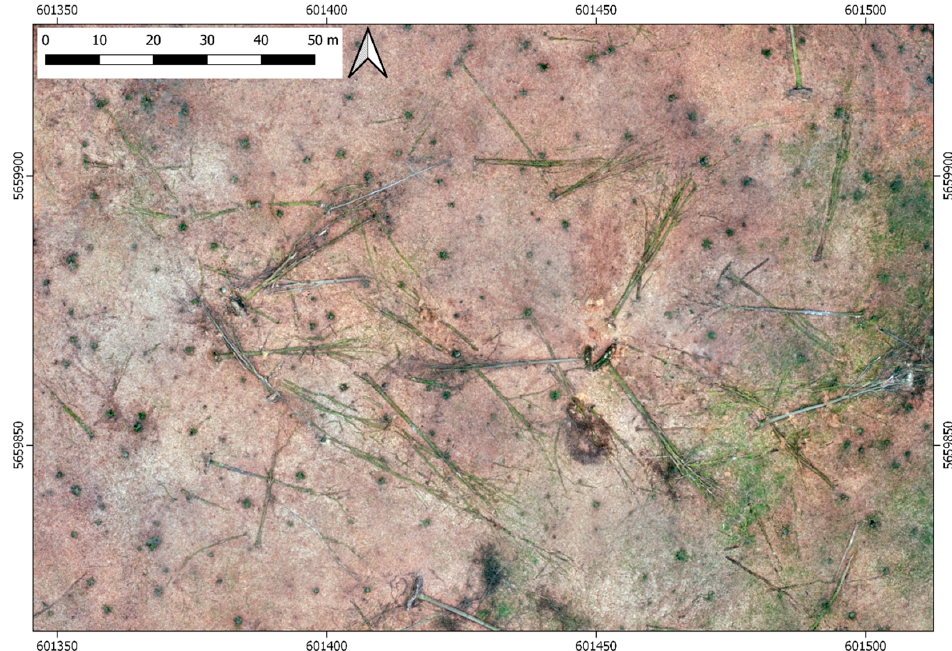
Figure 4. Subset of the canopy-free orthomosaic created and used for coarse wood debris (CWD) mapping in this study. The subset is identical to the one shown in Figure 4. UAS imagery was acquired during leaf-off season (acquisition date 24/03/2019). The dark dots represent the lower part of the stems of standing trees. The varying color of the dead wood corresponds to different species and stages of decomposition. Since some trunks have been lying on the forest floor for several years, advanced decay is found. Such logs feature almost the same elevation as the surrounding ground and might not be detected when only geometric properties are considered.